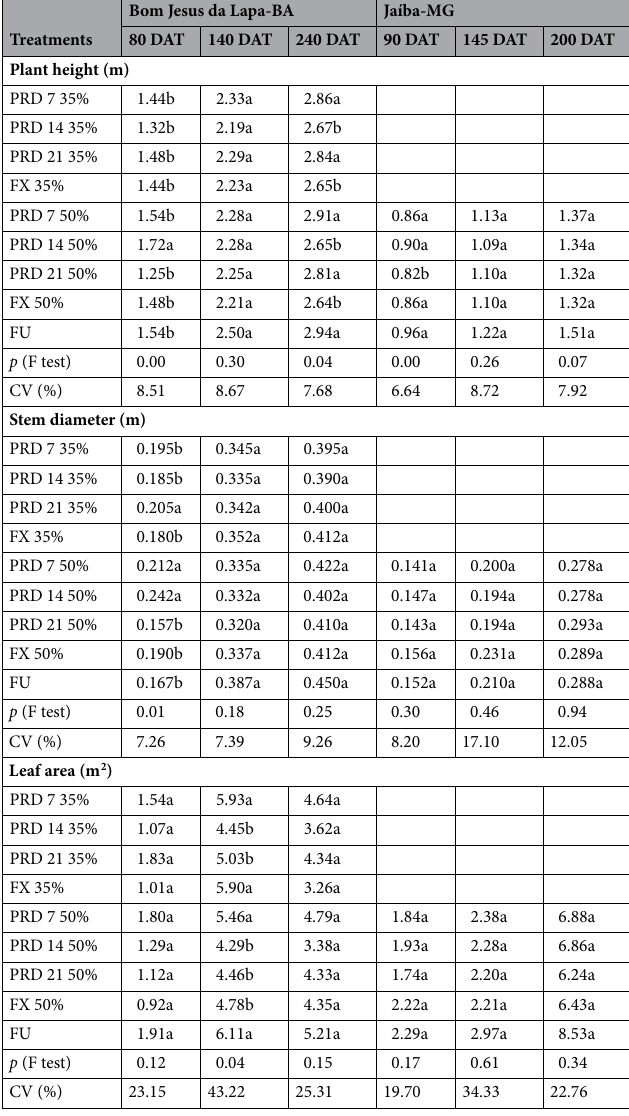
Table 2. Mean of plant height, stem diameter and leaf area of papaya cultivated under PRD: with alternation at 7, 14 and 21 days; FX: fixed irrigation on one side of the rootzone; and FU: full irrigation in different periods (days after transplanting, DAT), in Bom Jesus da Lapa-BA and Jaíba-MG. Means followed by the same letter in the column did not differ statistically by Scott-Knott test at 5% probability